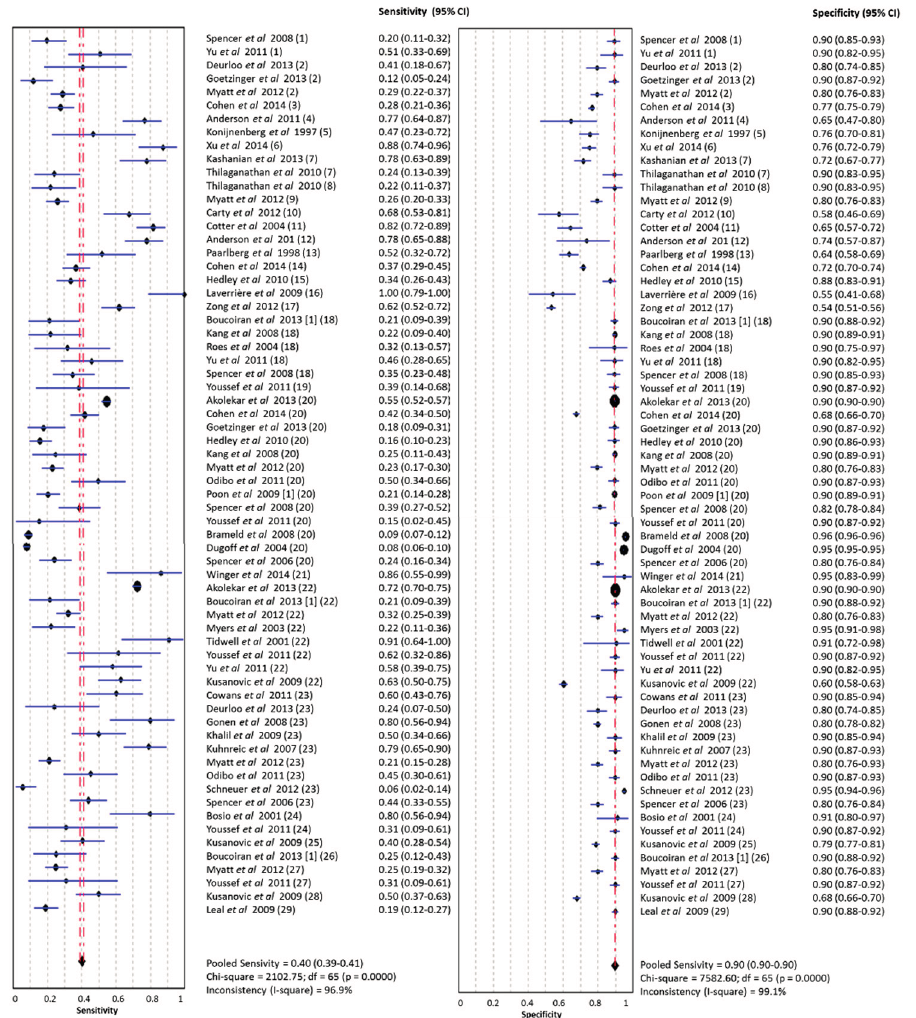
Figure 4. Meta-analysis of single laboratory biomarkers in PE (both EOPE and LOPE).